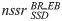
Single-state designability of MD_EnzBench conformations.Each of the 100 boxplots on the right represents 16 × 10 nssr values resulting from ten conformations generated by the MD simulation in a 100 ps interval for each of the 16 prot(k). As a control, the 16 × 20 nssrSSDBR_EB values of (single) enzdes designs generated for 20 protein-specific conformations from BR_EnzBench were summarized in a boxplot shown on the left (label Backrub). Whiskers indicate the lowest and the highest values of the 1.5 interquartile.